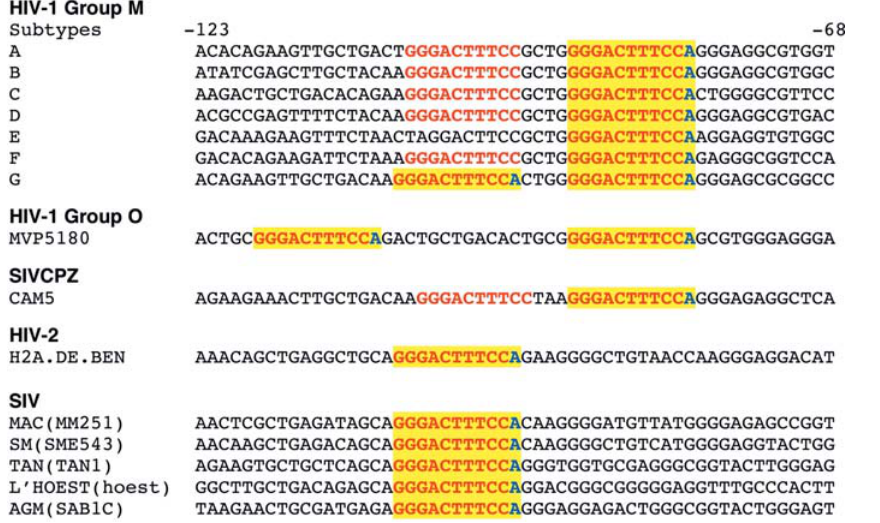
Figure 3. The NFAT5 Binding Motif Is Conserved in HIV-1, HIV-2, and SIV LTRs Sequence analysis of HIV-1 Group M subtypes A through G and HIV-1 Group O as well as HIV-2 and selected SIV LTR enhancer/promoter regions. Numbering is based on B subtype (HIV-1 LAI ) sequences. The conserved NFAT5 binding motif is highlighted in yellow; the sequence corresponding to the canonical NF- j B site is in red, and the unique 3 9 terminal adenine is in blue. Sequences were obtained from the Los Alamos HIV Sequence Database (http://hiv-web.lanl.gov/content/hiv-db/mainpage.html) [17,56] and aligned using HIV-1 subtype B sequences spanning (cid:1) 123 to (cid:1) 68 nt relative to the viral transcription start site as a reference.